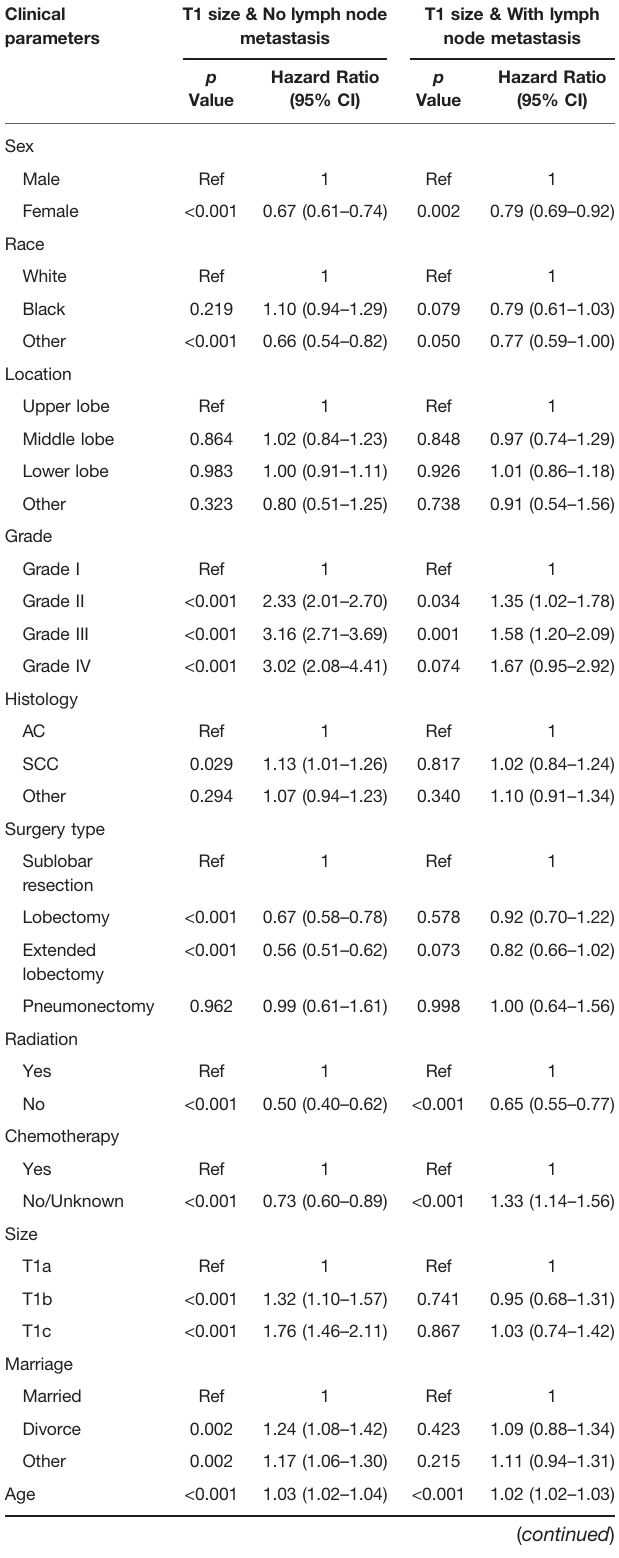
TABLE 2 | Multivariate COX regression of the prognostic factors of LCSS in patients without LN metastasis ( N =12,927) and with LN metastasis ( N =2,007). Clinical